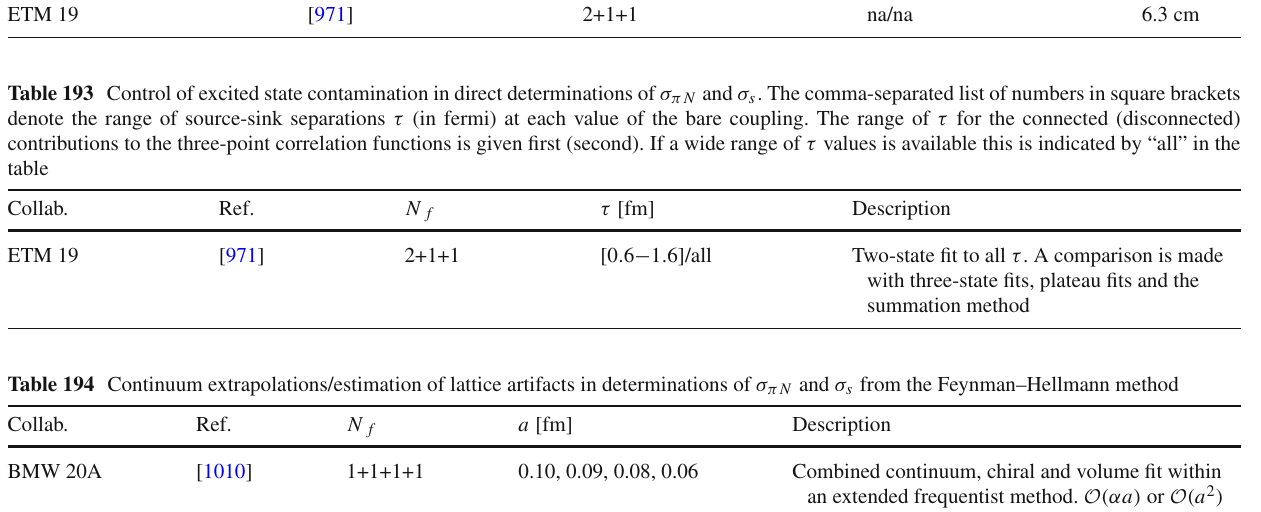
Table 192 Renormalization for direct determinations of σ π N and σ s . The type of renormalization (Ren.) is given for σ π N first and σ s second. The label ’na’ indicates that no renormalization is required Collab.